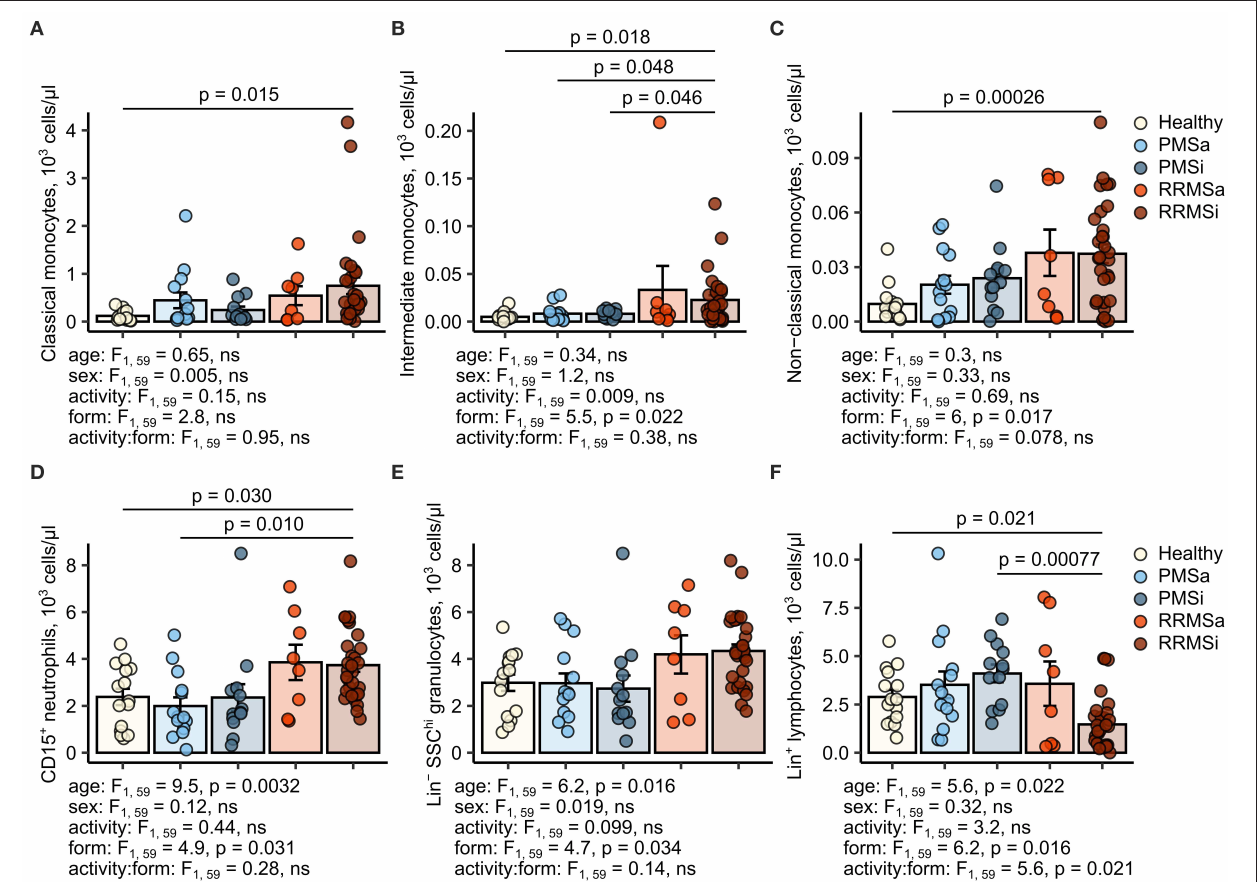
FIGURE 5 | Increased counts of neutrophils and classical and nonclassical monocytes in inactive relapsing-remitting multiple sclerosis (RRMSi) individuals. Lineage + lymphocytes, Lineage − SSC hi granulocytes, CD15 + neutrophils, and monocyte subpopulations were identified in whole-blood samples from healthy controls ( n = 15) and MS patients stratified by disease course type [active progressive MS (PMSa): n = 14, inactive progressive MS (PMSi): n = 13, active relapsing-remitting MS (RRMSa): n = 8 and RRMSi: n = 30] as presented in Supplementary Figure S1 . Levels of the studied populations are expressed as counts per microliter of whole blood. Each point denotes a single observation, bars depict group-wise means, and error bars represent SEM. Statistical significance was determined by one (healthy/MS disease status) and two-way (disease progression form, activity and form: activity interaction, MS collective) analysis of covariance (ANCOVA) with age and sex as confounders. Results of the two-way ANCOVA are presented under the plots. post hoc testing was performed with Benjamini–Hochberg-corrected two-tailed T tests. Significant results of post hoc test are presented within the plots. (A) Classical monocytes. ANCOVA for the disease status: F 1,76 = 5, p = 0.029; age: F 1,76 = 0.017, ns; sex: F 1,76 = 0.56, ns. (B) Intermediate monocytes. ANCOVA for the disease status: F 1,76 = 3.6, ns; age: F 1,76 = 0.007, ns; sex: F 1,76 = 0.22, ns. (C) Nonclassical monocytes. ANCOVA for the disease status: F 1,76 = 9.8, p = 0.0025; age: F 1,76 = 0.39, ns; sex: F 1,76 = 0.032, ns. (D) CD15 + neutrophils. ANCOVA for the disease status: F 1,76 = 5.8, p = 0.019; age: F 1,76 = 4.8, p = 0.032; sex: F 1,76 = 1.3, ns. (E) Lineage − SSC hi granulocytes. ANCOVA for the disease status: F 1,76 = 4.8, p = 0.031, F 1,76 = 3, ns, F 1,76 = 0.96, ns. (F) Lineage + lymphocytes. ANCOVA for the disease status: F 1,76 = 0.63, ns; age: F 1,76 = 1.5, ns; sex: F 1,76 = 0.23,